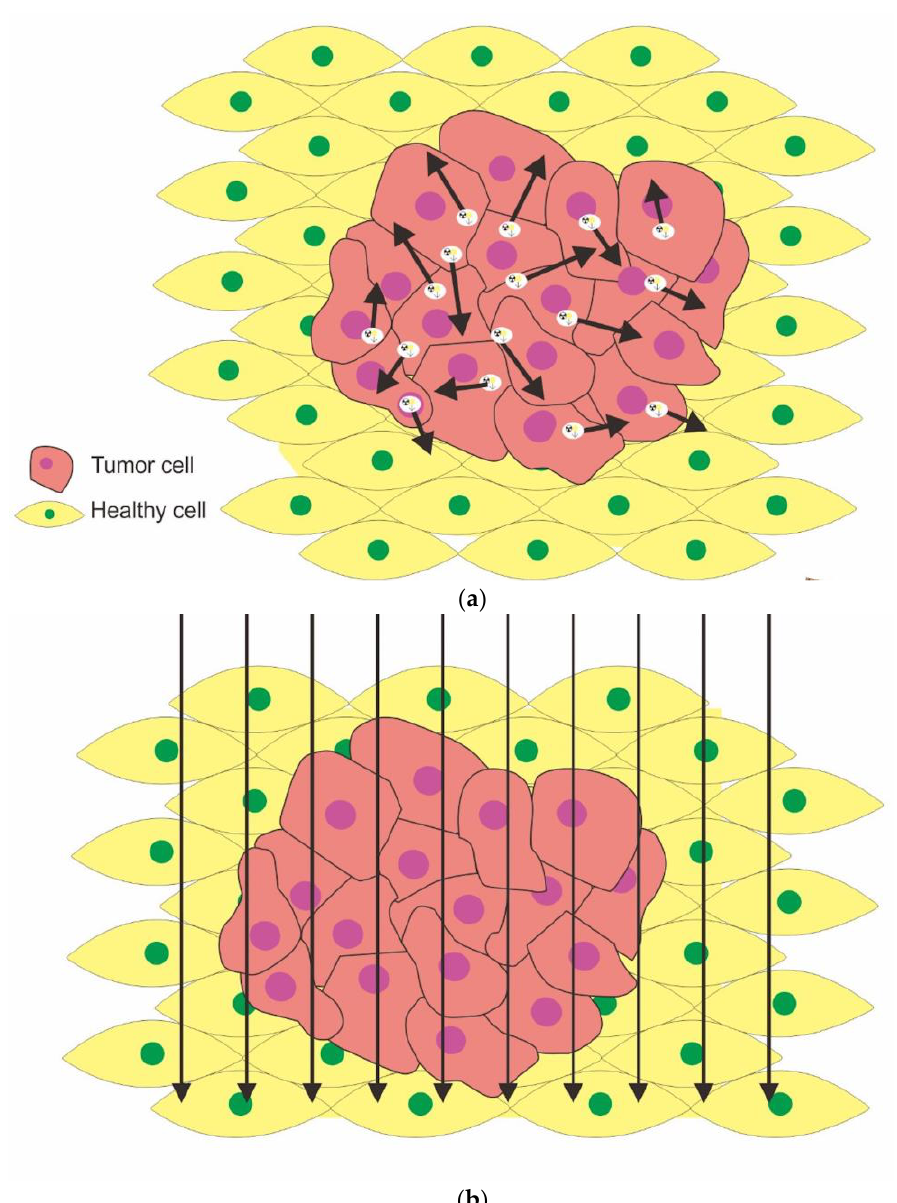
Figure 1. The cell’s radiation distribution by RPT ( a ) and external radiotherapy ( b ). Radiopharma- ceuticals are administrated intravenously to be delivered to a target tumor. The targeted tumor cell absorbs a dose of radiation which exponentially decreases over time. The tumor mass’s periphery cells will receive absorbed and crossfire doses from other target cells ( a ). Radiation beams are directed at tumor tissue in external radiotherapy and can also affect healthy cells ( b ).